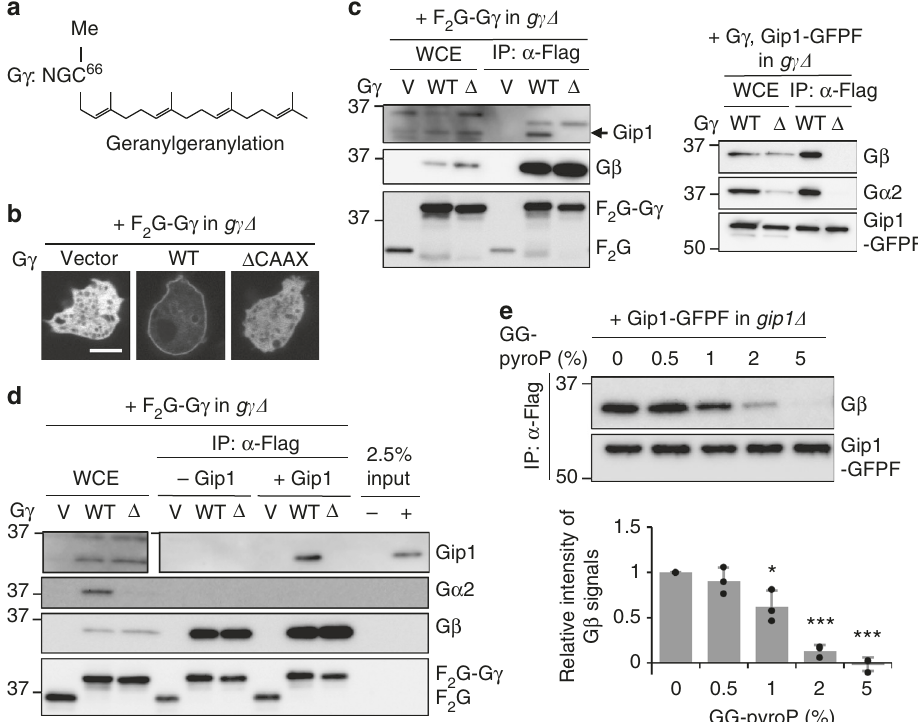
Fig. 3 Recognition of the prenyl group on G γ by the hydrophobic cavity of Gip1. a Schematic diagram of G γ modi fi cation. C-terminal cysteine (C 66 ) is geranylgeranylated and methylated (Me). b Subcellular localization of G γ in a living cell. Flag-Flag-GFP (F 2 G) tag alone (vector) or F 2 G-tagged G γ (WT) or G γ ( Δ CAAX) in g γΔ cells. Scale bar, 5 μ m. c Co-immunoprecipitation of G γ or Gip1. F 2 G-G γ (WT) or F 2 G-G γ ( Δ CAAX) was expressed in g γΔ cells (left). GFP-Flag-tagged Gip1 (Gip1-GFPF) was coexpressed with G γ (WT) or G γ ( Δ CAAX) in g γΔ cells (right). Pull-down samples of G γ (left) and Gip1 (right) were immunoblotted with the indicated antibodies. d In vitro interaction between G βγ and puri fi ed Gip1. G βγ subunits were bound to beads and incubated with puri fi ed full-length Gip1. e Competitive dissociation of G proteins from Gip1 by geranylgeranyl pyrophosphate (GG-pyroP). The data were normalized relative to the band intensities without GG-pyroP and presented as the mean ± SD of three independent experiments ( n = 3, * P < 0.05, *** P < 0.001 versus 0% GG-pyroP, two-tailed unpaired Student ’ s t